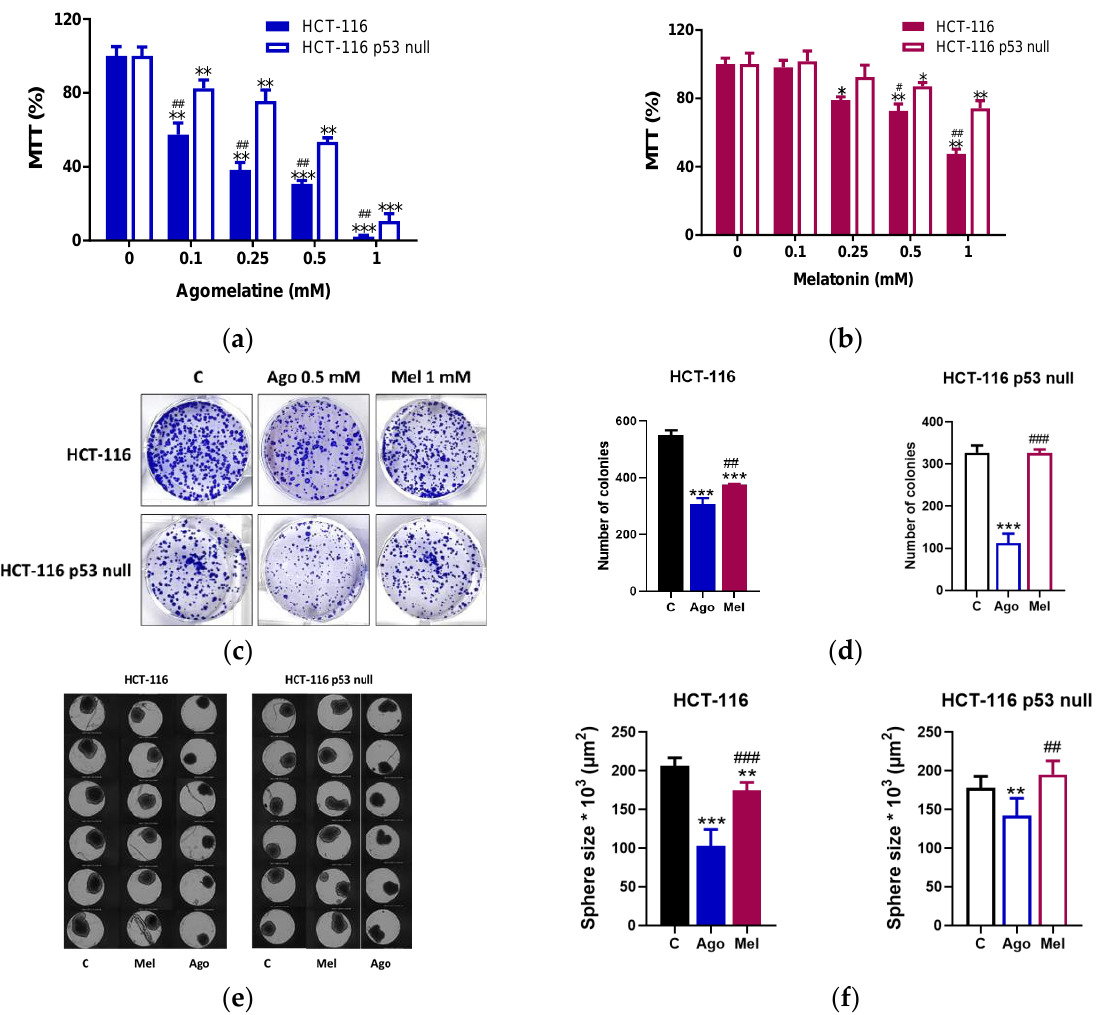
Figure 1. Inhibition of viability on HCT-116 and HCT-116-p53-null cells by ( a ) agomelatine and ( b ) melatonin. The results represent the mean ± SD of three experiments performed in quadruplicate. * p < 0.05 vs. C; ** p < 0.01 vs. C; *** p < 0.001 vs. C; ## p < 0.01 vs. the same concentration of agomelatine (Ago) or melatonin (Mel); # p < 0.05 vs. the same concentration of melatonin (Mel) or agomelatine (Ago). ( c ) Representative example of colony-formation assay and ( d ) graphical representation of three experiments in HCT-116 and HCT-116-p53-null cells after treatment with agomelatine (Ago) (0.5 mM) and melatonin (Mel) (1 mM) versus control (C) cells. Results are presented as means ± SD. *** Values of p < 0.001 versus C; ## p < 0.01 vs. agomelatine; ### p < 0.001 vs. agomelatine. In other experiments, ( e ) HTC-116 and HCT-116-p53-null cells were cultured in a 3D model and ( f ) the size of the spheroids was measured in control and after agomelatine (Ago) (0.5 mM) and melatonin (Mel) (1 mM) treatments during 72 h. ** Values of p < 0.01 vs. C; *** p < 0.001 vs. C; ## p < 0.01 vs. melatonin; ### p < 0.001 vs. melatonin.